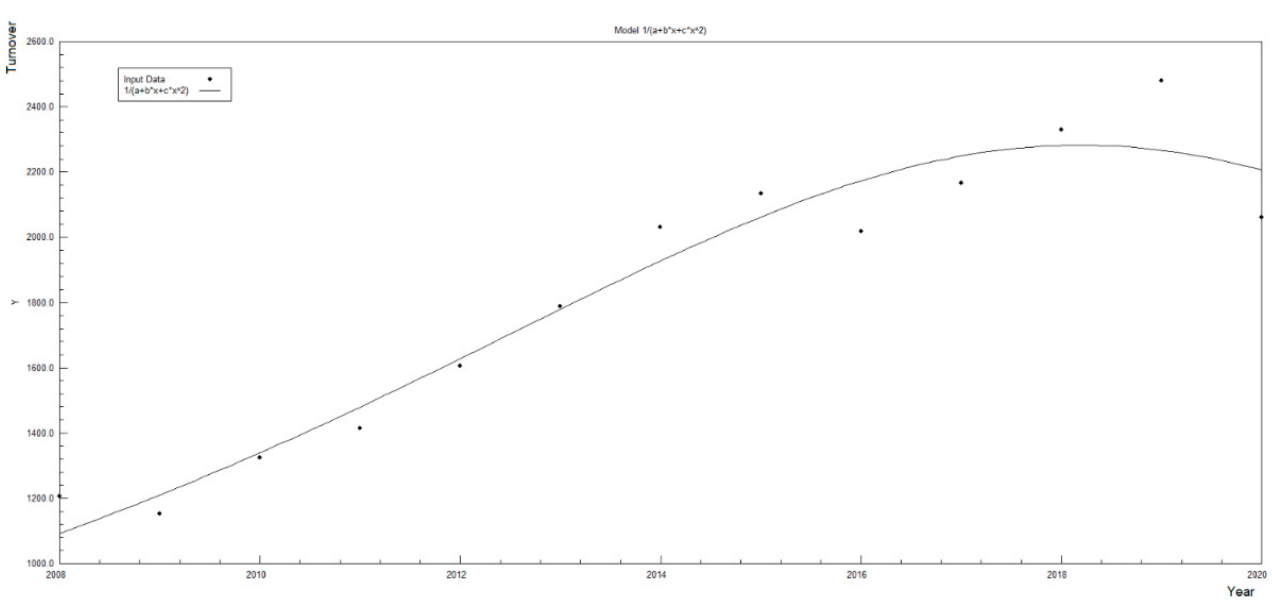
Figure 9. Model Definition graph: Y = 1/(a + b ∙ x + c ∙ x 2 ). Table 9. Values of the coefficients of the mathematical model as a result of the regression for the considered data set.